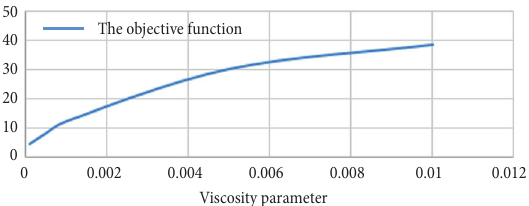
Fig. 7. The value of the objective function versus viscosity parameter in uniaxial compression test